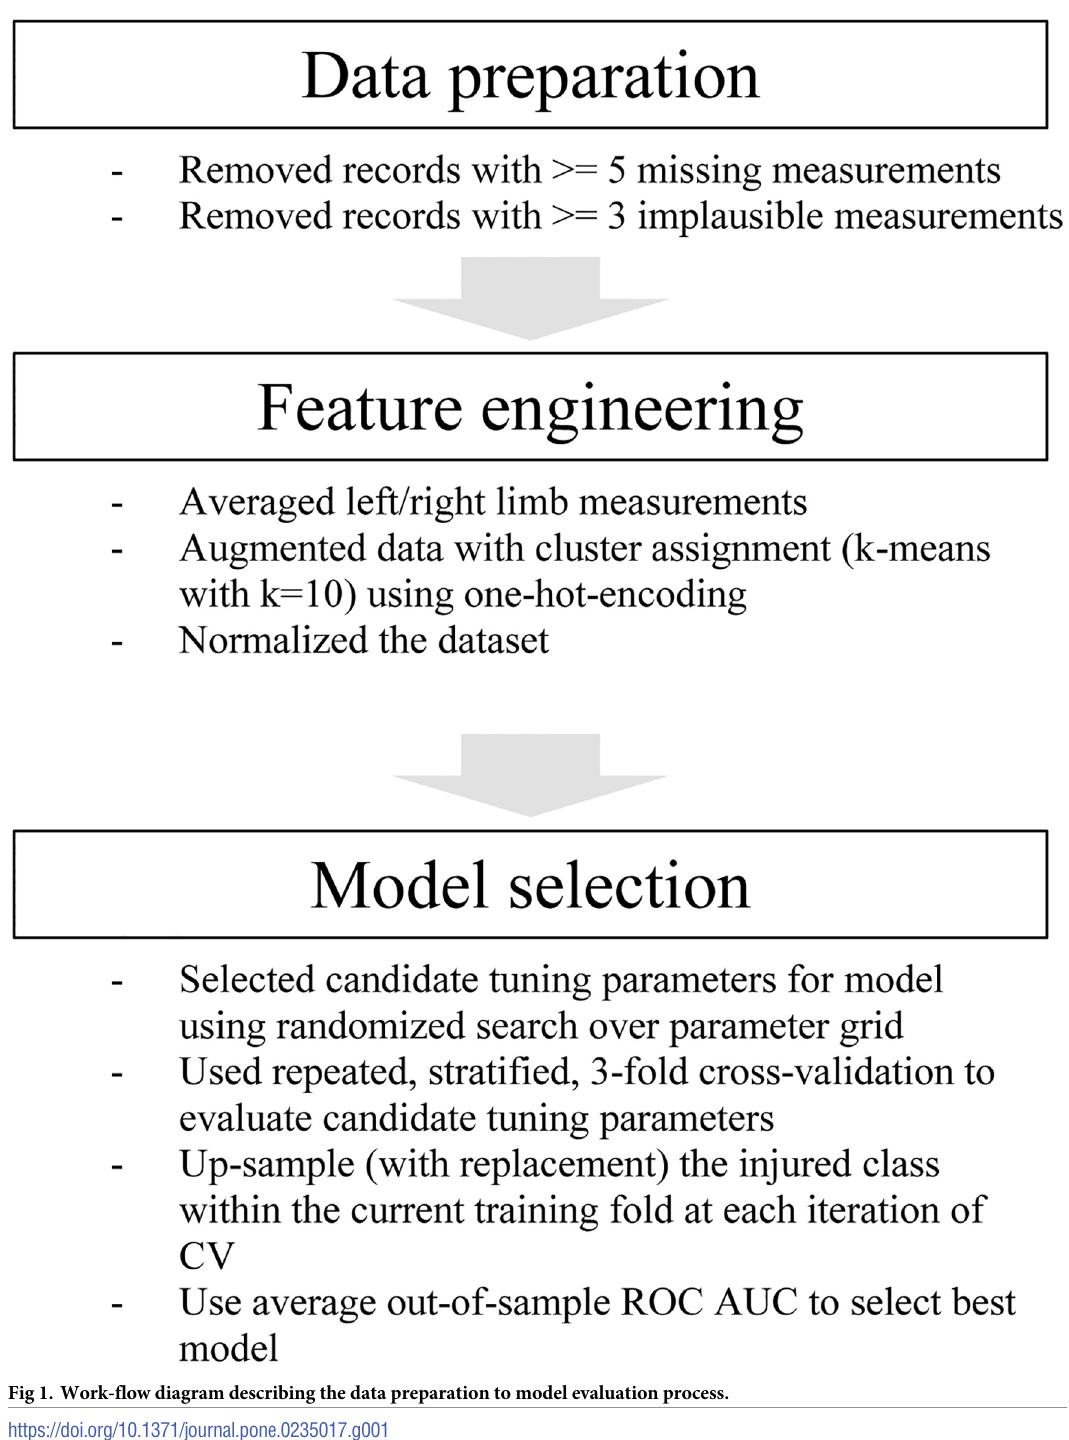
Fig 1. Work-flow diagram describing the data preparation to model evaluation